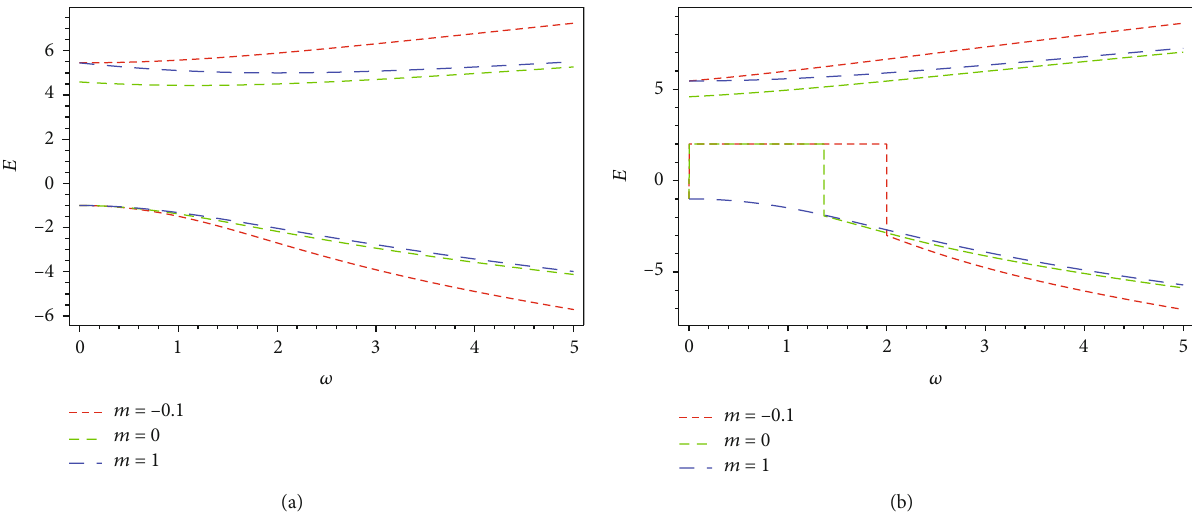
Figure 1: Illustration of the energy eigenvalues in the spin symmetry limit (equation (34)) as a function of the parameter ω for (a) s = 1 and (b) s = − 1 . We use units such as M = 1 , n = 1 , a = 1 , and an upper bound ε = 10 − 7